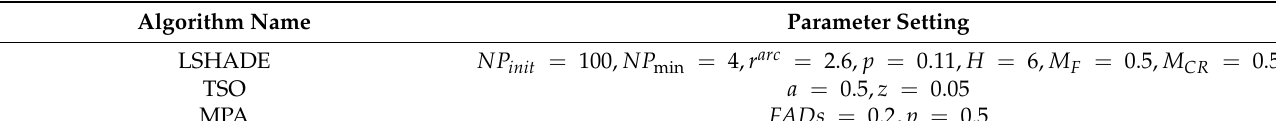
Table 4. Algorithm parameter setting table.